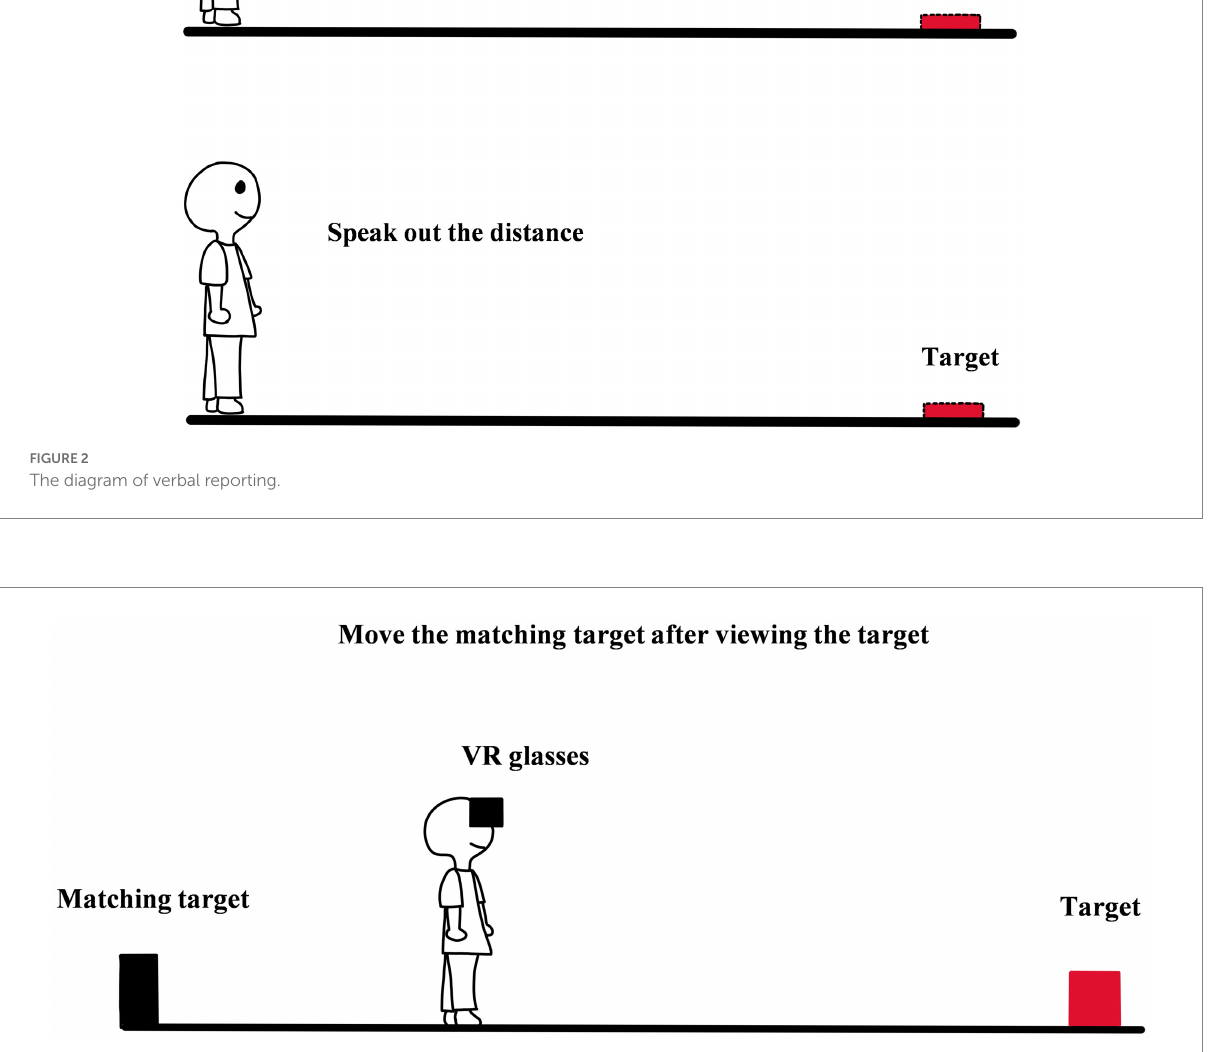
FIGURE 3 The diagram of perceptual distance matching (in virtual